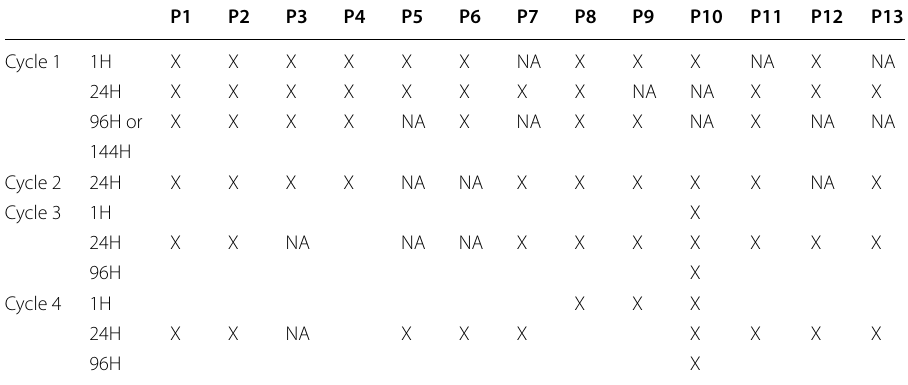
Table 1 SPECT/CT acquisition time‑points for all patients of the patient cohort, all cycles. NA: planned but not available, X: